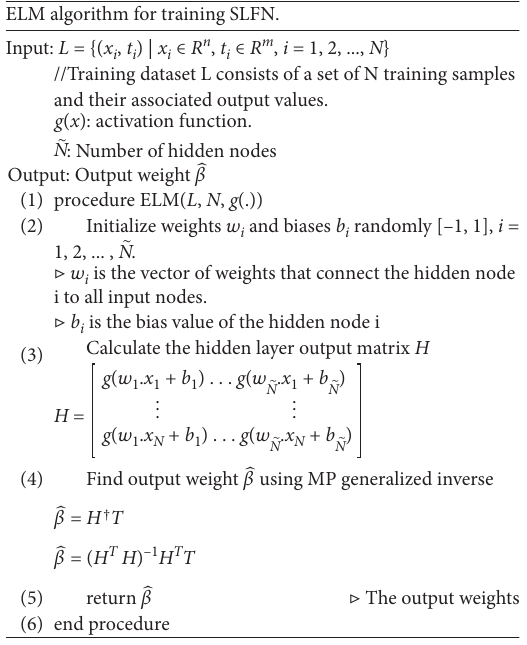
Figure 4: The extreme learning machine model learning